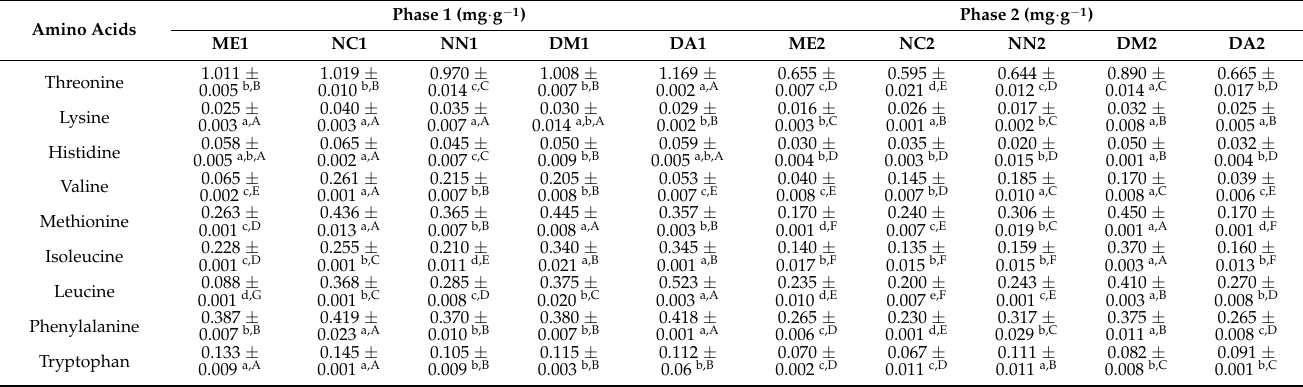
Table 4. Amino acid scores (AAS) for phase 1 and phase 2 infant formulas calculated for children aged 0–6 to 7–12 months. Amino Acids